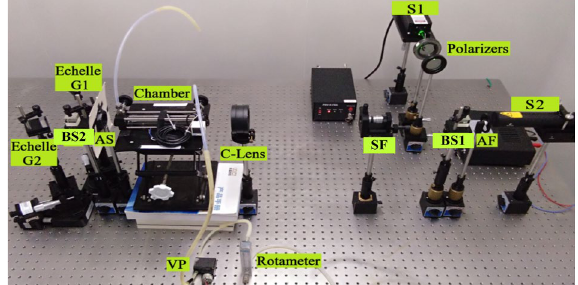
Figure 1. Experimental platform of visual gas sensing system with narrow